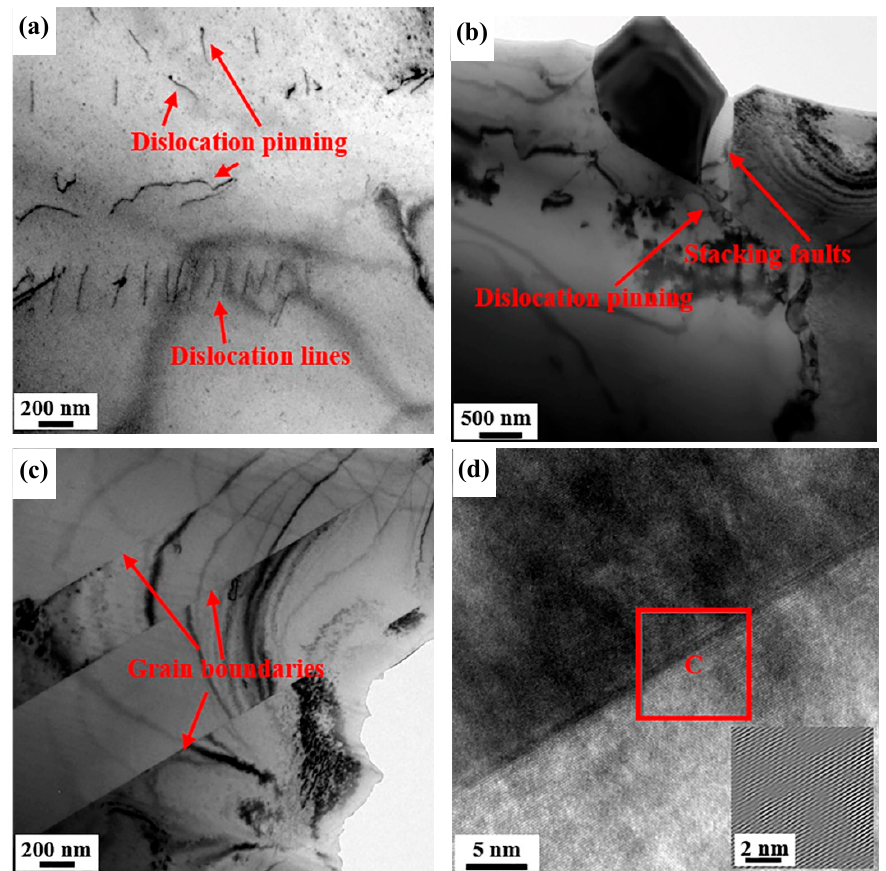
Figure 8. TEM images of the AFA steel annealed at 1150 °C for 30 min after 30% cold deformation. ( a ) Dislocation lines and pinning, ( b ) dislocation piled-ups and stacking faults, ( c ) annealing twin boundaries and ( d ) HRTEM of ( c ) with IFFT of Area C.